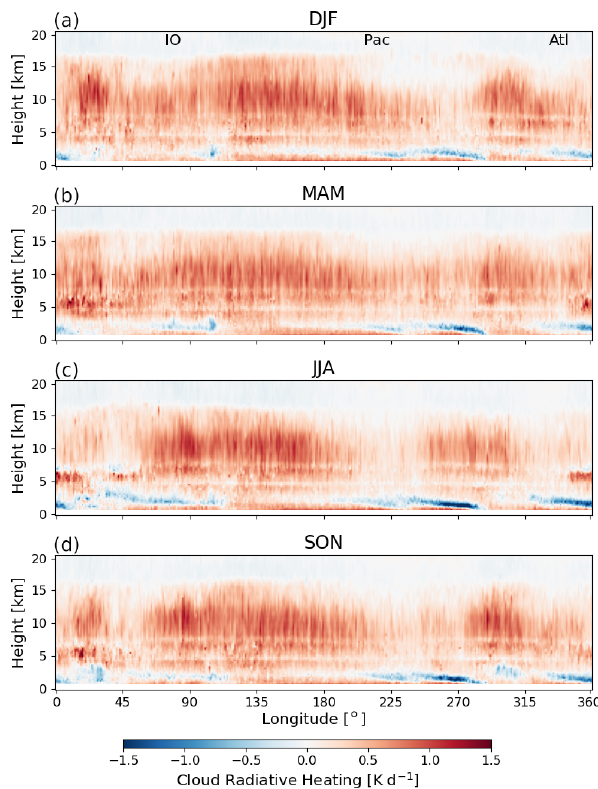
Figure 1. The vertical structure of cloud radiative heating based on the 2B-FLXHR-LIDAR dataset (CloudSat/CALIPSO) aver- aged between latitude ± 30 ◦ . IO indicates the Indian Ocean, Pac indicates the Pacific Ocean, and Atl indicates the Atlantic Ocean. The longitude bins are spaced at 1 ◦ . (a) December– February (DJF), (b) March–May (MAM), (c) June–August (JJA) and (d) September–November